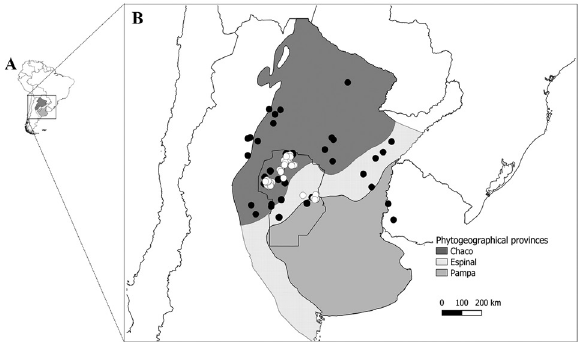
Figure 1. A Location of the study area (Córdoba province) in South-America; B Location of Córdoba province in cen- tral Argentina and overall distribution of Trithrinax camp- estris (black dots) in Argentina and Uruguay (according to Cano et al. (2013) and Flora australis database) and sample plots (relevés; white dots) collected in this study in Córdoba province. The location of Chaco (dark grey), Espinal (light grey), and Pampa (intermediate grey) phy- togeographic provinces in central and northern Argenti- na are depicted based on Cabrera